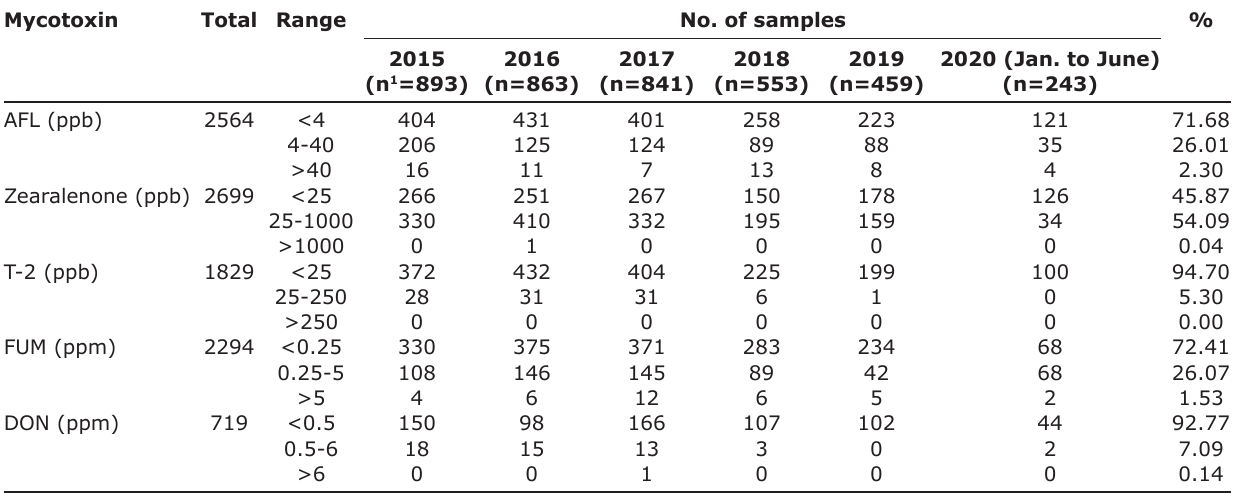
Table-1: AFL, ZEA, T-2, FUM, and DON contamination in feed samples in the central part of Thailand from 2015 to 2020. Mycotoxin